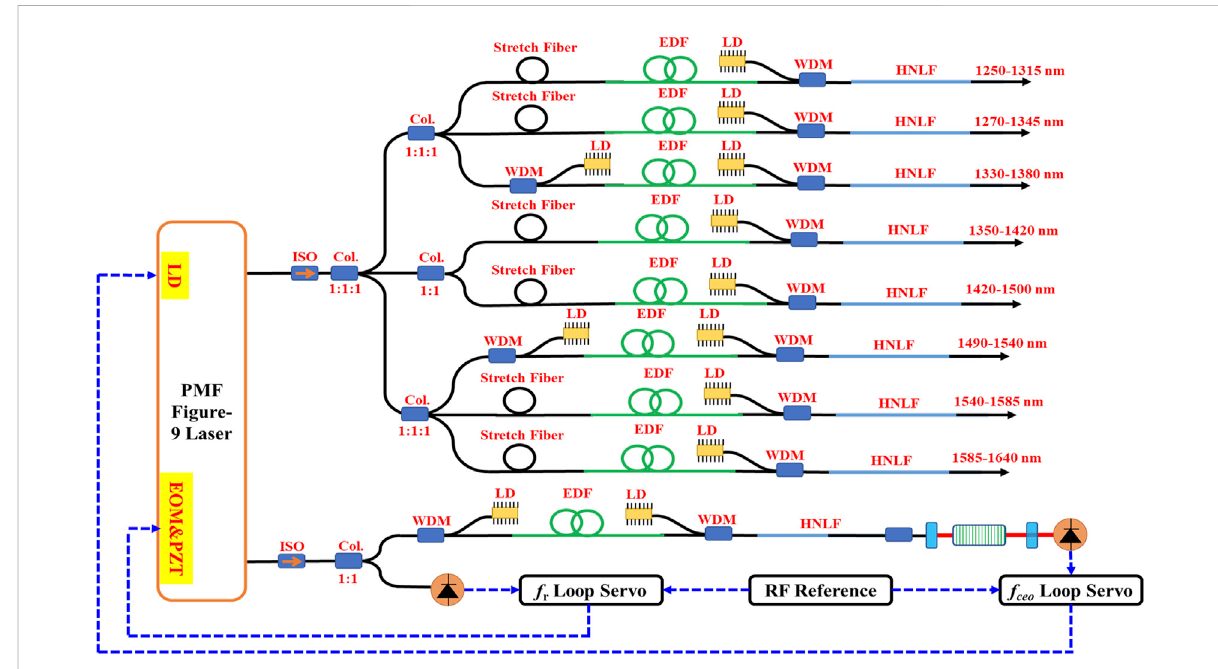
FIGURE 1 Experimental setup of frequency comb broadband spectroscopy. LD: laser diode; ISO: optical isolator; WDM: wavelength division multiplexer; Col: collimator; EDF: Er-doped fi ber; HNLF: high nonlinear fi